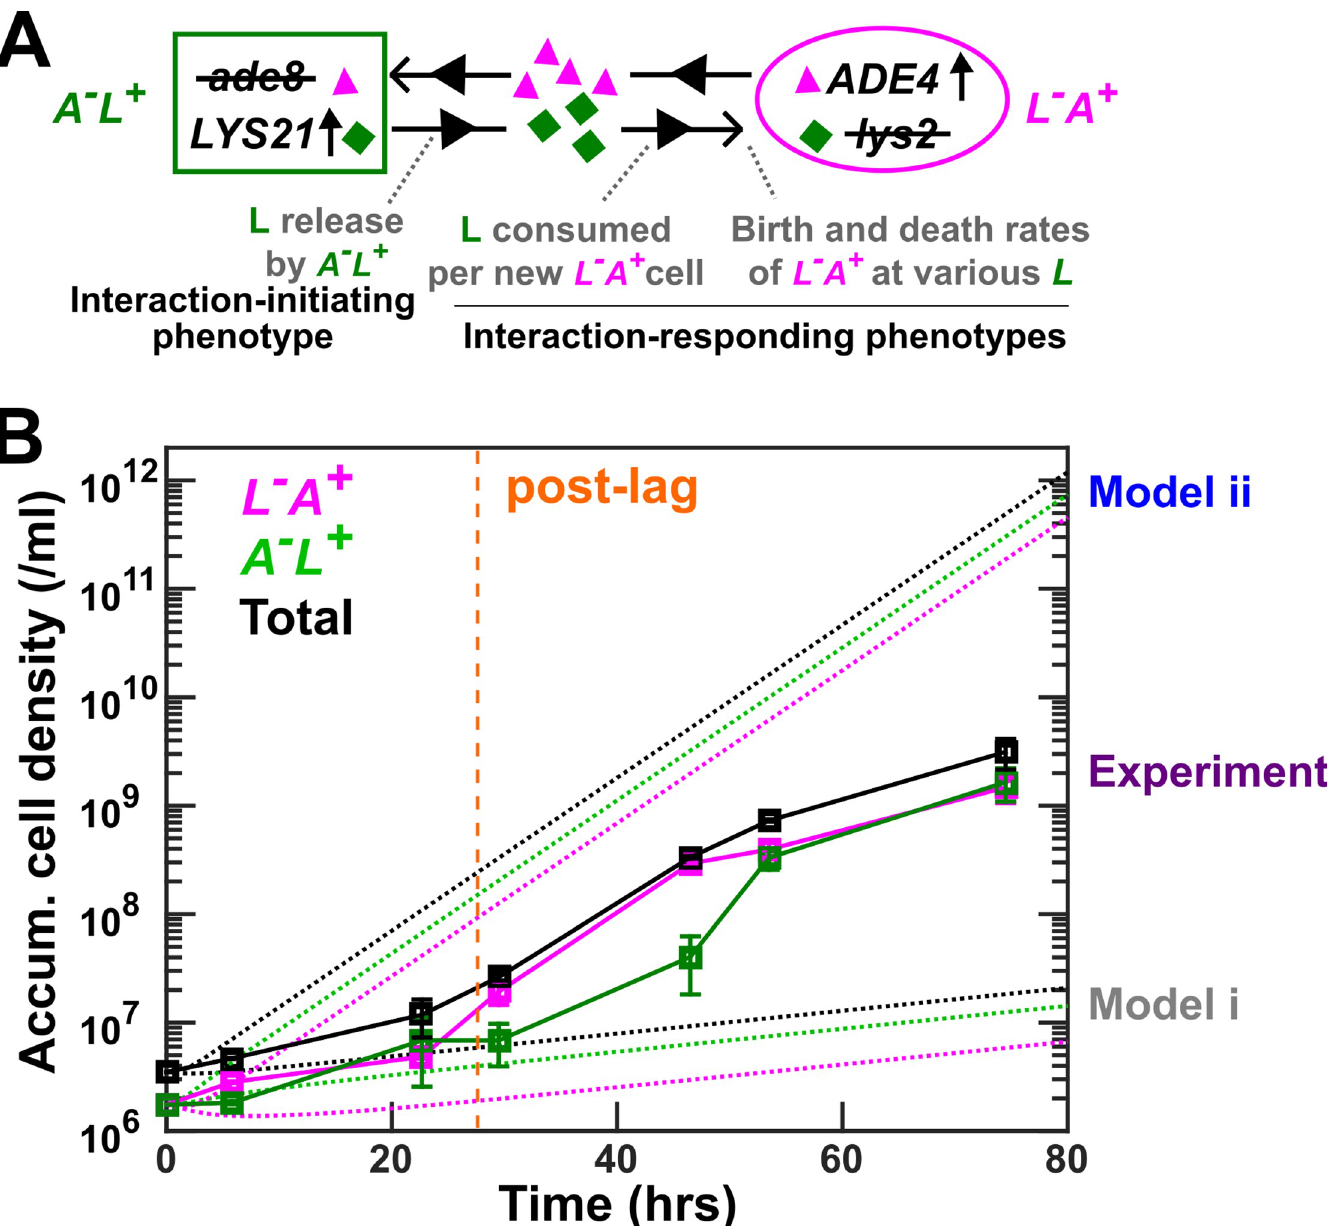
Fig 1. Model–experiment discrepancy in CoSMO growth dynamics. ( A ) CoSMO comprises two non-mating, cross-feeding yeast strains expressing different fluorescent proteins. Here, we use the lysine-mediated interaction as an example to illustrate interaction-initiating and interaction-responding phenotypes. ( B ) Model– experiment discrepancy. In experiments (squares; data listed in S1 Data), L − A + and A − L + growing exponentially in excess lysine or adenine were washed free of lysine or adenine and preconditioned (“Strain culturing and preconditioning” in Methods). They were mixed at 1:1 in SD at time zero to form CoSMO, which was then cultured in a well-mixed environment and diluted with SD as needed to ensure that no other nutrients were limiting. Population dynamics were tracked using flow cytometry (“Flow cytometry” in Methods), and dilutions were taken into account when calculating accumulative cell densities. CoSMO initially grew slowly (prior to orange dashed line), and then grew faster. We simulated CoSMO population dynamics (dotted lines; S1 Code) using Eqs 1–4, where parameters were measured in batch cultures (S2 Table). Models i and ii differed in that the release rates of the two strains were borrowed from our previous measurements in the S288C background (Model i) or directly measured in the RM11 background (Model ii). ADE4 and LYS21 : over-active mutant versions of the ADE4 and LYS21 genes, respectively; ade8 and lys2 : deletion mutations of the ADE8 and LYS2 genes, respectively; CoSMO, Cooperation that is Synthetic and Mutually Obligatory; L, lysine; SD, Synthetic Dextrose minimal